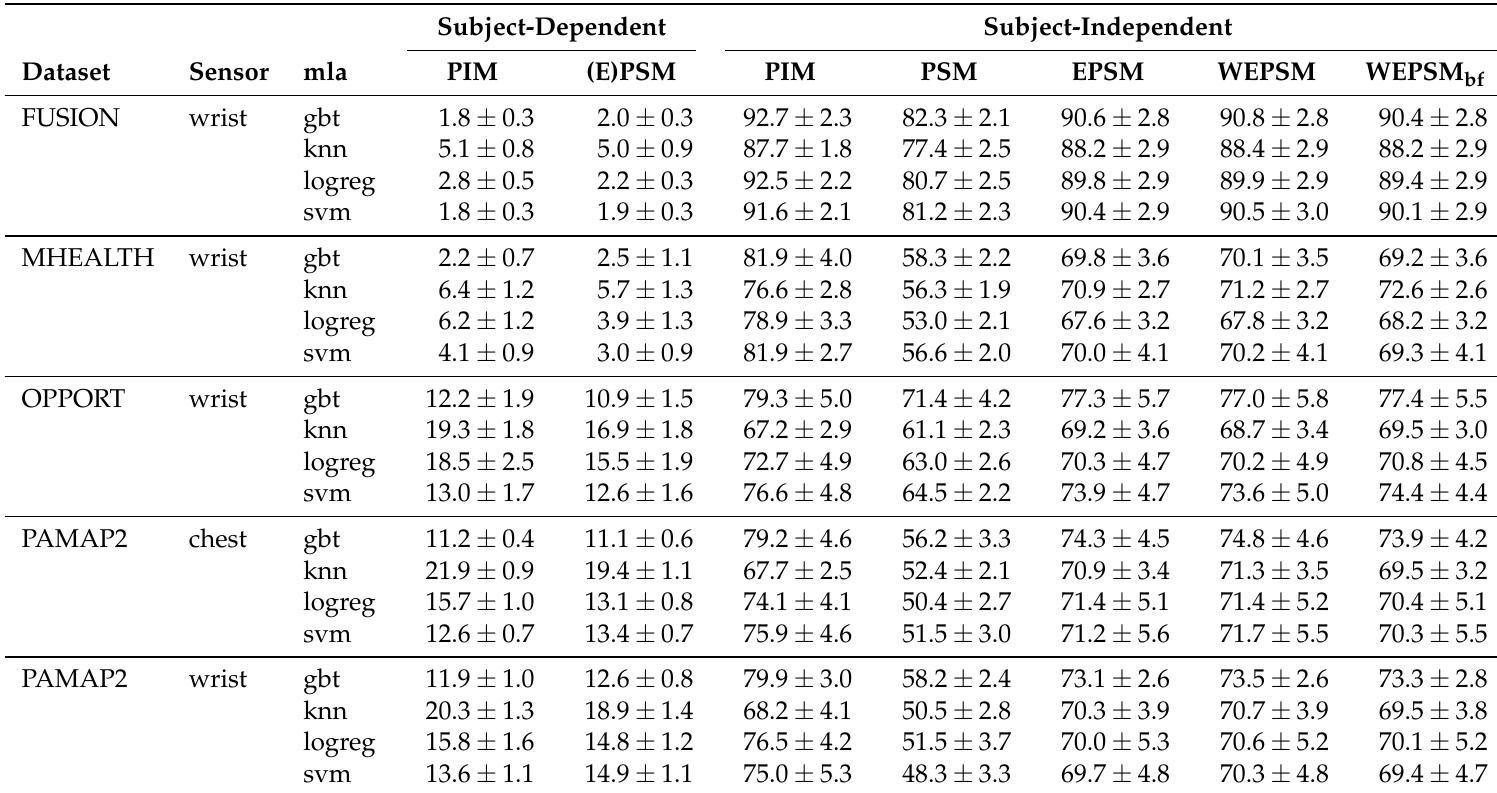
Table A2. Subject-dependent and subject-independent error rate (%) ± standard error when learning algorithms (mla) are combined with a person-independent model (PIM), a person-specific model (PSM), an unweighted ensemble of PSMs (EPSM), a κ -weighted EPSM (WEPSM), or a baseline-feature-weighted EPSM (WEPSM bf